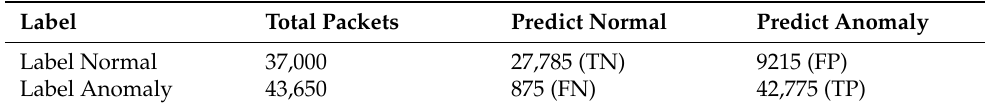
Table 11. Classification results of the ANC approach with the UNSW-NB15